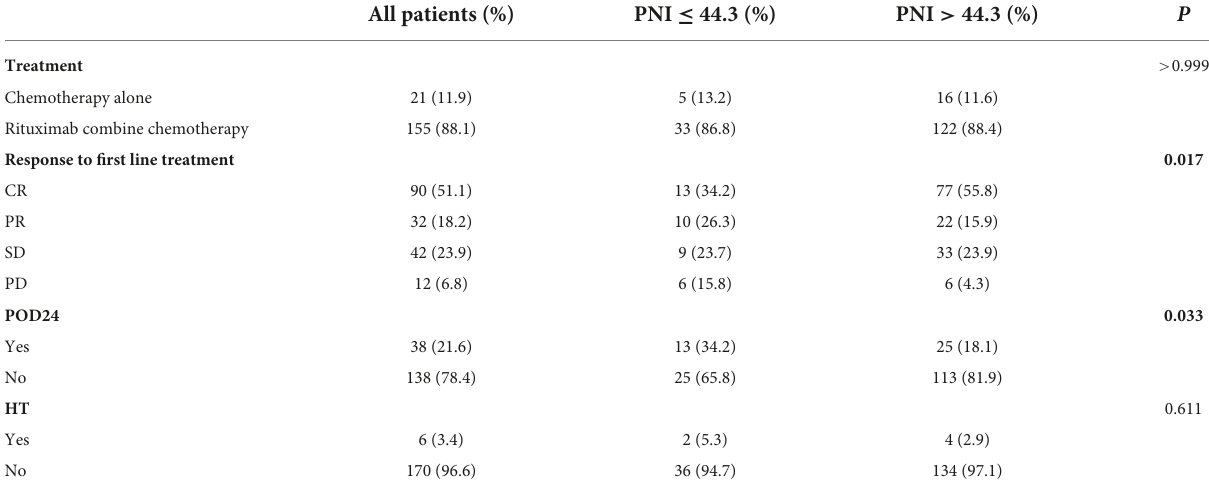
TABLE 2 Treatment and response data for FL patients.